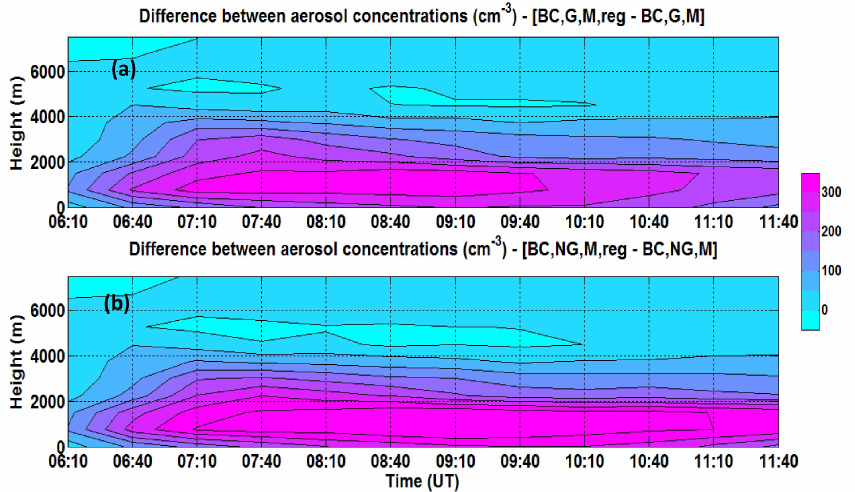
Fig. 13. Height profile of the average difference between aerosol concentrations (in cm-3) for the entire simulation time (06:00–12:00UT) in the area which is marked by a red rectangle in Fig.